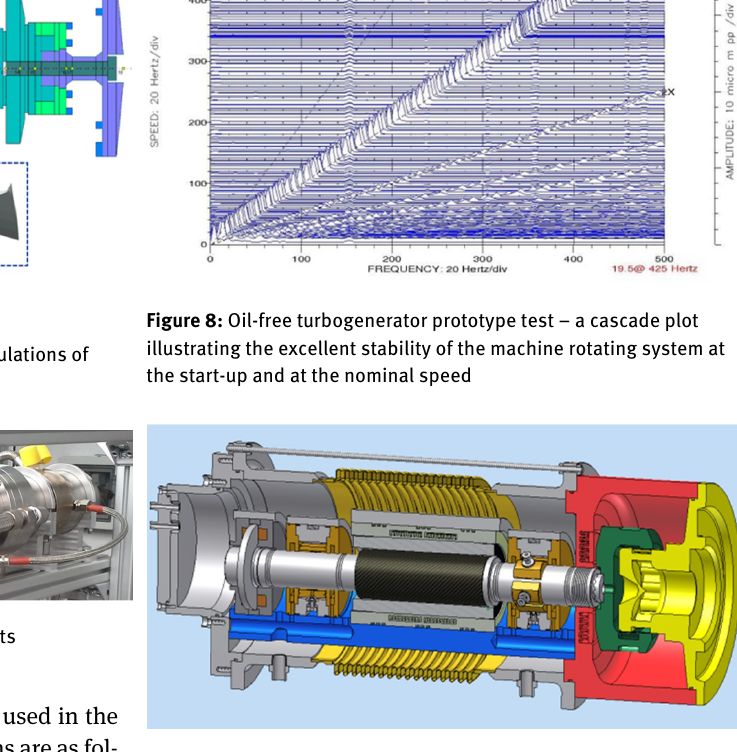
Figure 9: 3D model of the 70 kW turbogenerator equipped with oil- free hybrid